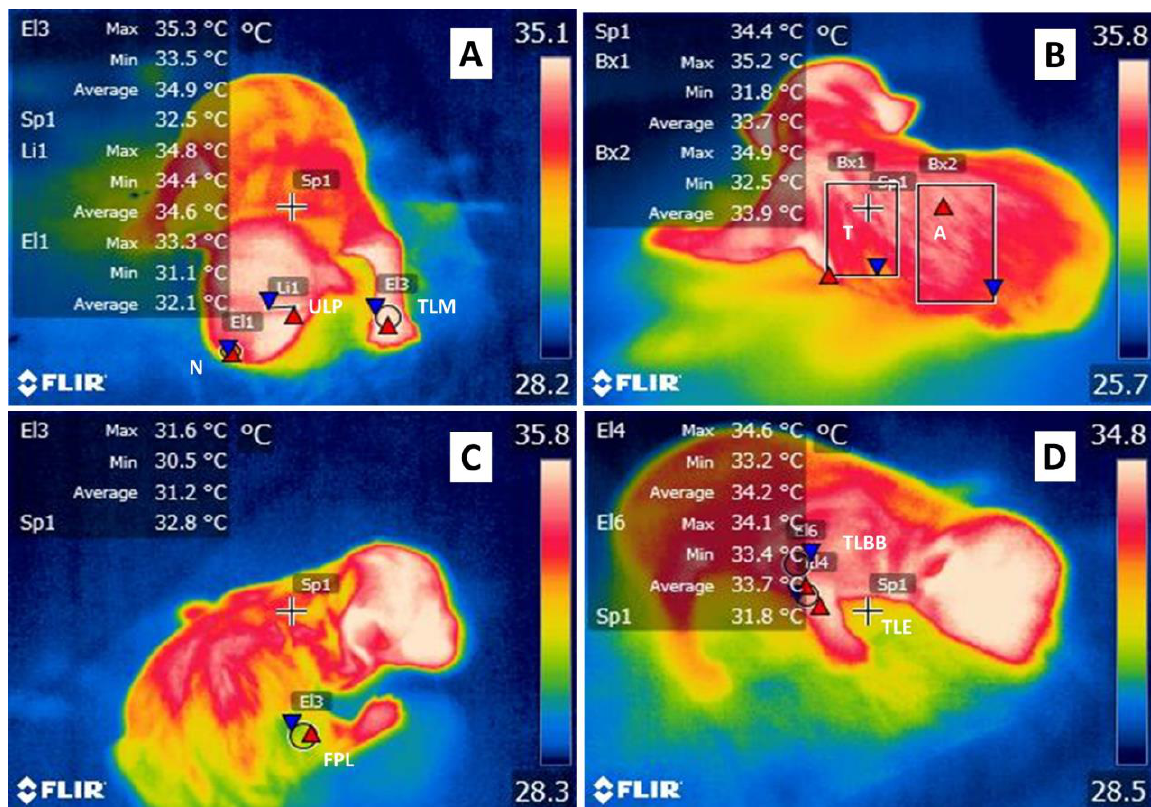
Figure 1. Thermal windows in newborn puppies. ( A ) Nasal (N) (El1), upper left palpebral (ULP) (Li1), and thoracic limb metacarpal (TLM) (El3) windows were made with circular figures delimited by the edges of the nasal mucosa, at the area of the edge of the left upper eyelid, and in the joint formed by the metacarpals covering the area from medial to lateral end, respectively. ( B ) Thoracic (T) window (Bx1) was made with rectangular figures delimited by the axillary area, the area of the last rib, and from the region of the spinal vertebrae to the ventral part of the abdomen. ( A ) Abdominal window (Bx2) was delimited by two millimeters after the last rib, to the inguinal area, and from the region of the spinal vertebrae to the ventral part of the abdomen. ( C ) Femoral pelvic limb (FPL) window (El3) was delimited by the space bounded by the edge of the pelvic limb in the biceps femoris region. ( D ) Thoracic limb brachial biceps (TLBB) (El6) and thoracic limb elbow (TLE) windows (El4) were obtained by placing circular figures from the area where the armpit begins to half the width of the thoracic limb and placing circular figures in the elbow area covering the vertex formed by the humerus-radio-ulnar joint,